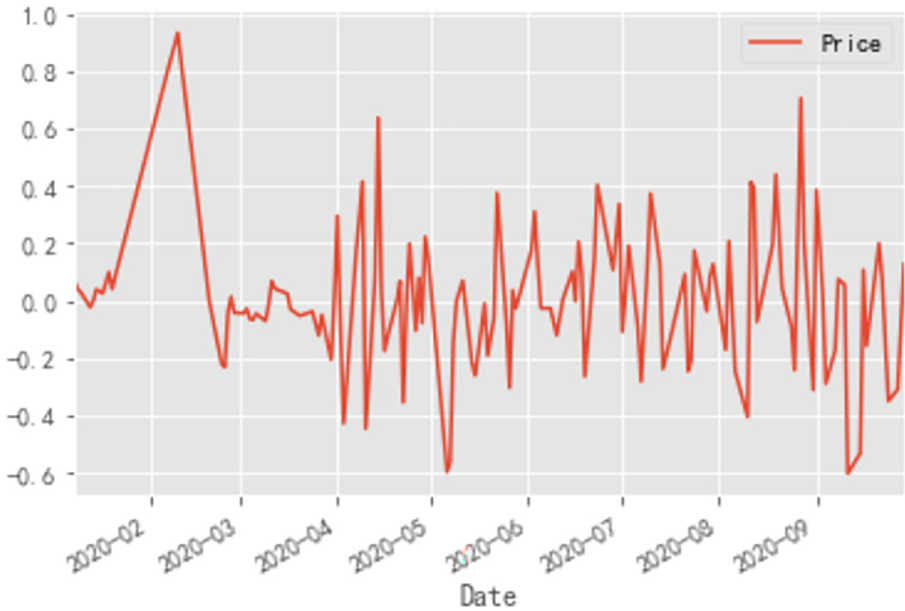
Fig 15. Second-order difference time series diagram of cabbage